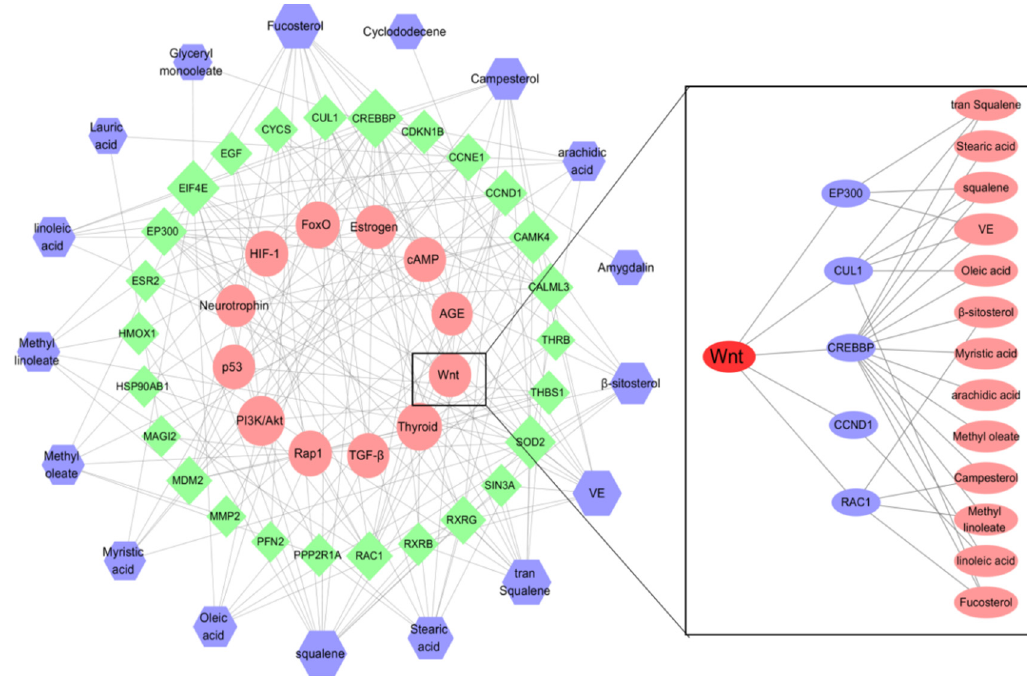
Figure 8. “The kernel of P. mira composition-target-signal pathway” network diagram.